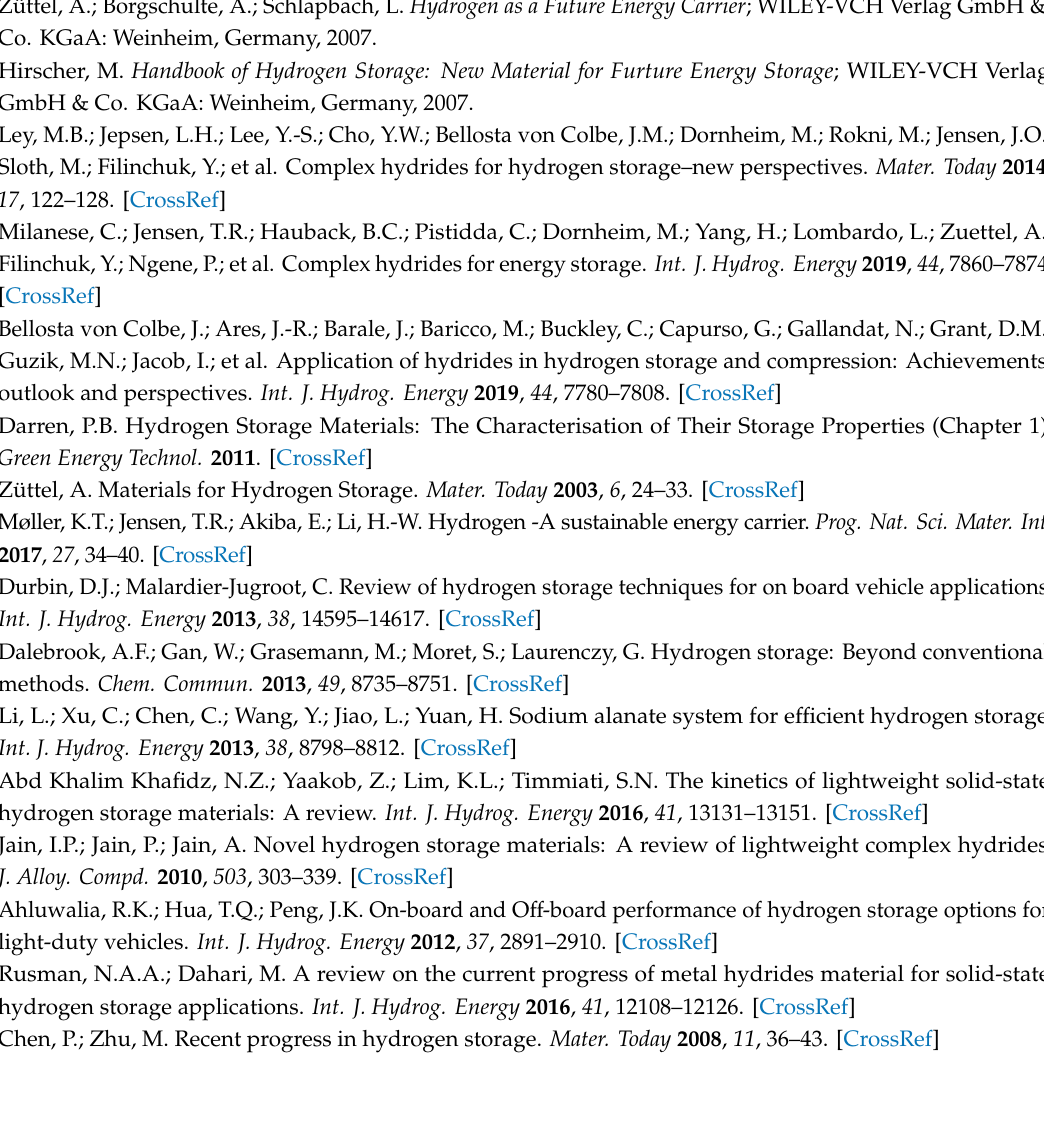
Figure S1: EDX spectrum. Figure S2: Thermogravimetric analysis of the TPX TM polymer (heating rate 10 K / min) under argon atmosphere. Figure S3: DSC heating and cooling traces (2nd cycle) for the TPX TM polymer (heating rate 10 K / min) under nitrogen